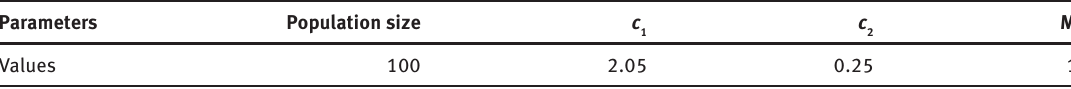
Table 2: Adopted Control Parameters of the IPSO Algorithm. Parameters